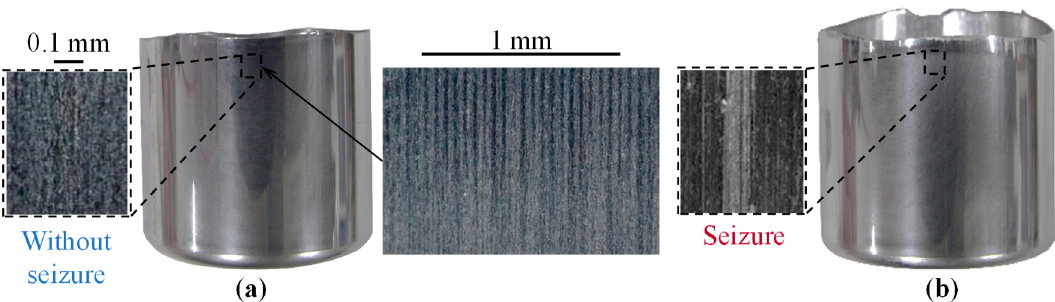
Figure 16. Stainless steel cup obtained after ironing with a grid array pa tt ern having d = 30 µm, h = 2 µm, and L = 50 µm, applying lubricant containing an extreme pressure additive at ( a ) r = 17%, and ( b ) at r = 23%.